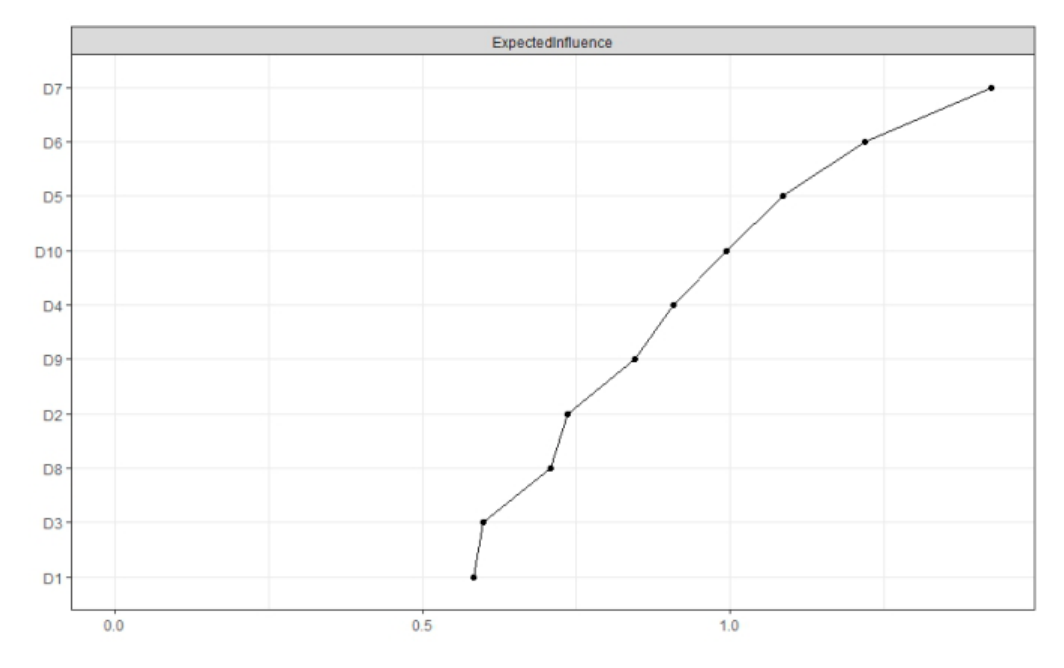
Figure 3. Network-centrality-expected influence for depression. Note. Higher values of expected influence reflect greater node centrality. D1 = bothered by things; D2 = difficulty keeping mind; D3 = depressed mood; D4 = everything is an effort; D5 = hopelessness about the future; D6 = fear; D7 = poor sleep; D8 = unhappiness; D9 = loneliness; and D10 = could not get going.